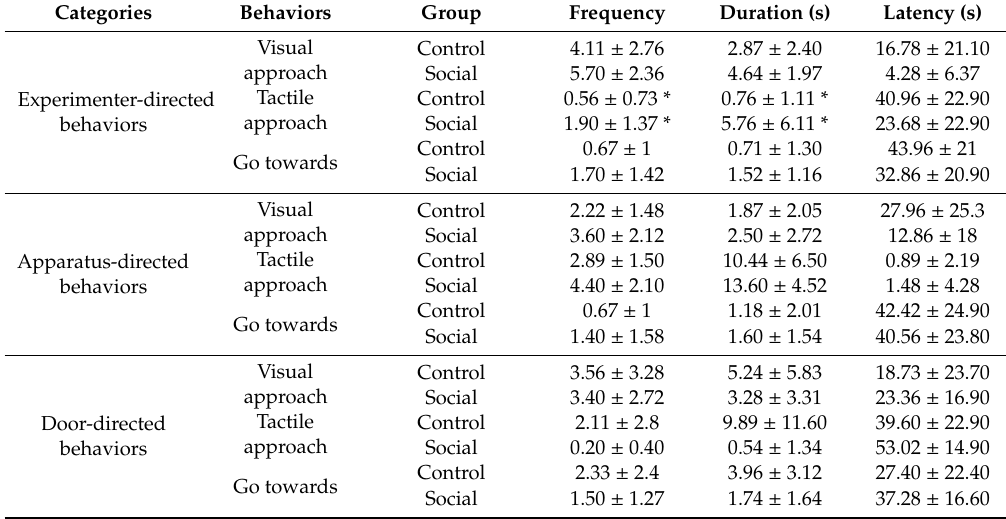
Table 2. Mean ± standard deviation of behaviors coded during the impossible trial. * indicates significant di ff erences ( p < 0.05) between the control group and socialized